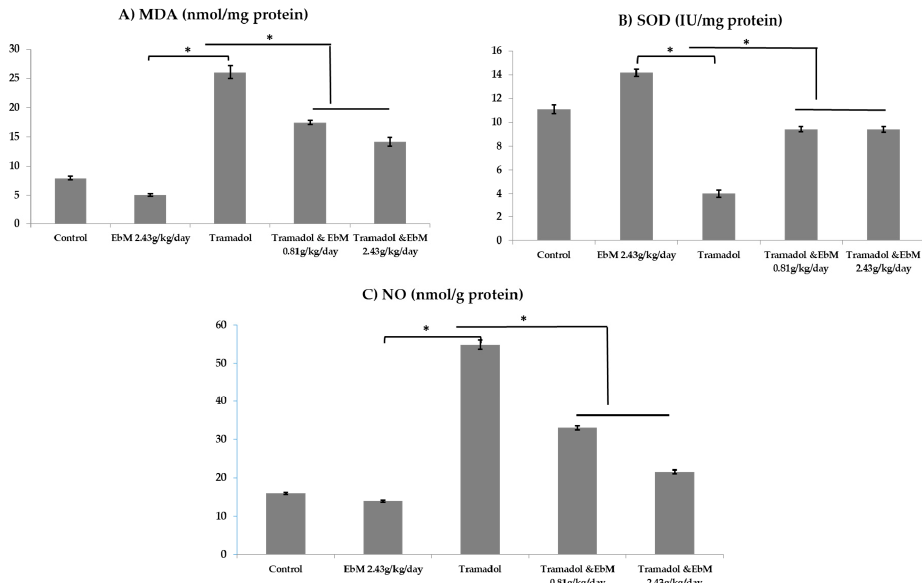
Figure 5. The effect of oral uptake of E. brevicornum extract and/or tramadol on malondialdehyde (MDA) ( A ), superoxide dismutase (SOD) ( B ), and nitric oxide (NO) ( C ) activity concentrations in testes of male